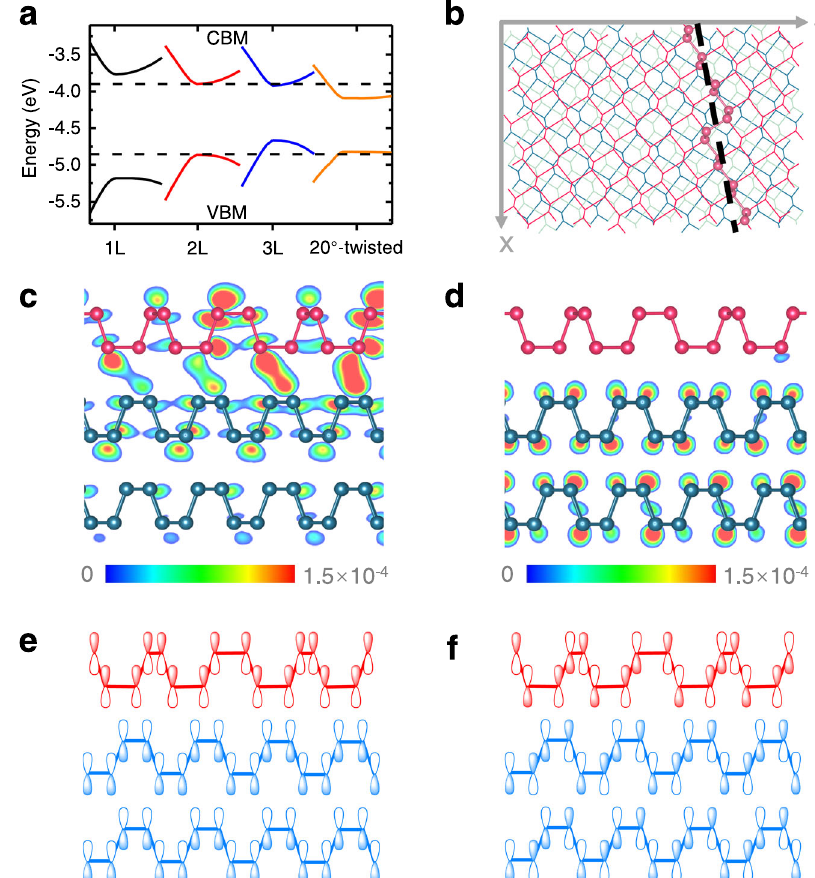
Fig. 4 Strong interlayer coupling in the 20° twisted monolayer/bilayer phosphorene heterostructure. a Band alignment of the monolayer (black solid line), bilayer (red solid line), trilayer (blue solid line), and 20° twisted phosphorene heterostructure (orange solid line) near Γ points. The two black dashed lines indicate the CBM and VBM of bilayer phosphorene. The vacuum energy is set to be at 0 eV. b The schematic top-view of the supercell of the 20° twisted phosphorene heterostructure. The red, cyan, and blue colors indicate the top, middle, and bottom phosphorene layers, respectively. The black dashed lines indicate the section plane for the partial charge density distributions, where the nearest phosphorus atoms are displayed in a ball-and-stick model. c , d The sectional partial charge density distribution at the CBM ( c ) and VBM ( d ) of the 20° twisted phosphorene heterostructure along the armchair direction of the constituent bilayer phosphorene, as indicated by the black dashed lines in ( b ). The isosurface levels are set to be 1.5 × 10 − 4 eÅ − 3 , as indicated by color scale bar. The wavefunctions of the monolayer (red) and bilayer phosphorene (blue) are strongly coupled at the CBM, whereas, they are mainly localized in the bottom bilayer at the VBM. e , f Schematic illustration of the overlapping of wavefunctions at the CBM ( e ) and VBM ( f ) in 20° twisted phosphorene heterostructure. The CBM electron wavefunctions have the same sign at the monolayer – bilayer interface ( e ), leading to constructive interference of interlayer coupling at different atom sites and strong hybridization between the monolayer and bilayer phosphorene. On the other hand, the VBM electron wavefunctions exhibit oscillating signs at the monolayer – bilayer interface ( f ), resulting in destructive interference of interlayer coupling at different atom sites and weak coupling of valence band